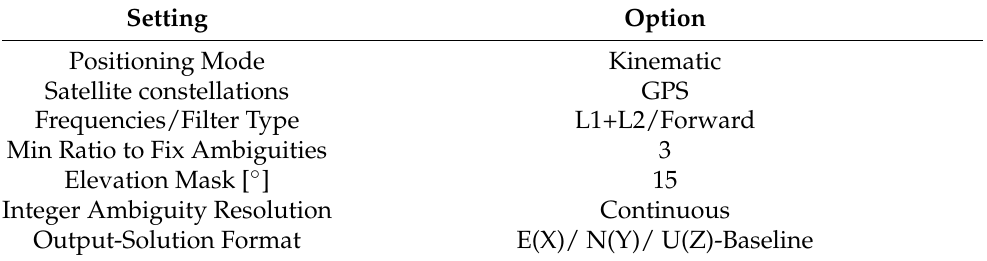
Table 2. RTKNAVI processing configurations—PPK